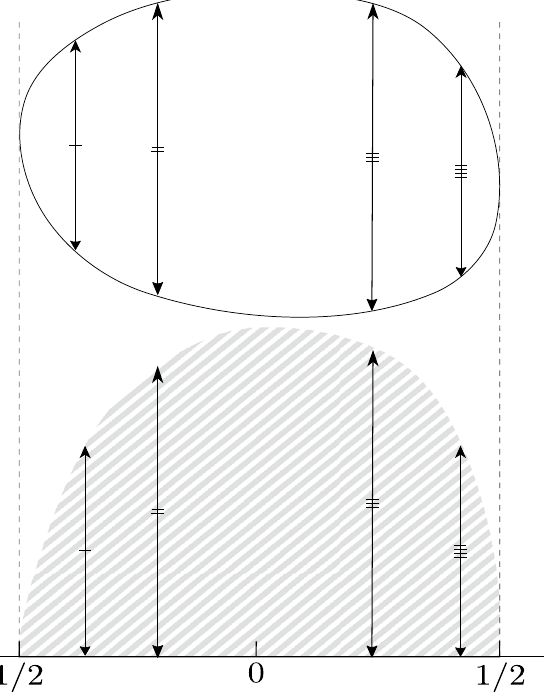
Figure 2. Projection procedure applied to an exemplary domain. All the probability mass in two dimensions (the oval shape up) is projected onto a given axis, i.e. moved down leaving lengths of the depicted arrows intact, resulting in one dimensional mass (schematically shown as grey area below); then it is